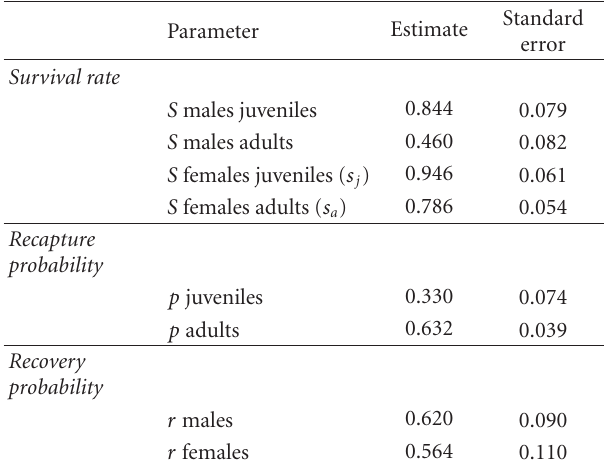
Table 2: parameter value estimates after averaging of the two best fitting models from Table